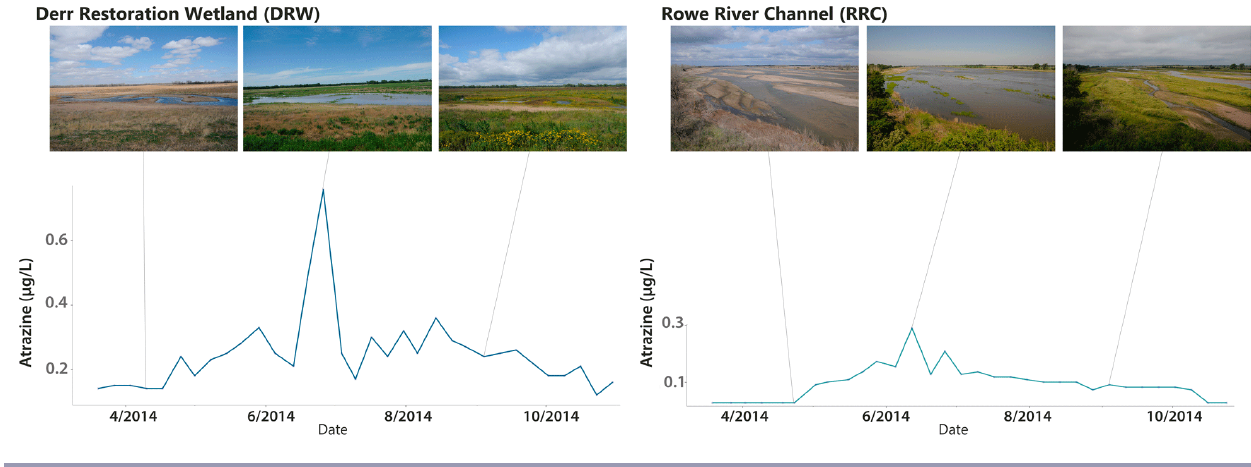
Fig. 10 . Time-lapse data sequences at Derr Resotration Wetland and Rowe River Channel showing fluctuations of Atrazine from March to November of 2014. Atrazine is a commonly applied herbicide for agricultural